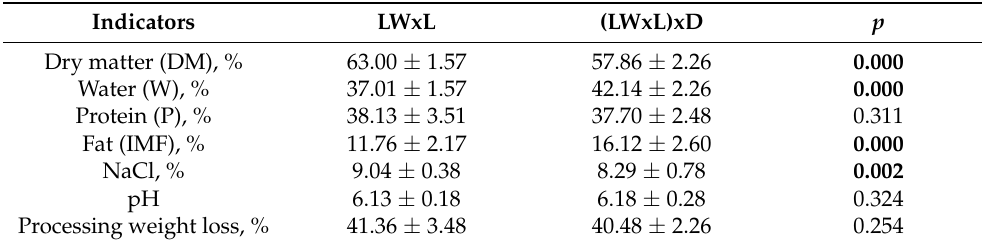
Table 2. Differences between pig genotypes in basic-chemical properties (means ± standard error) of matured Istarski pršut